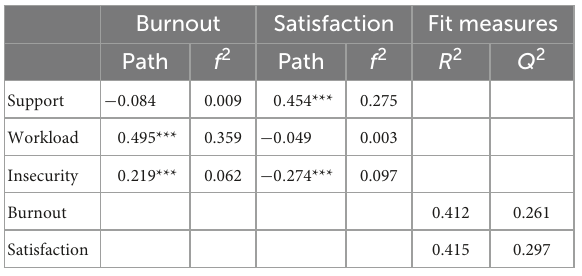
TABLE 2 Results of the SEM-PLS analysis.